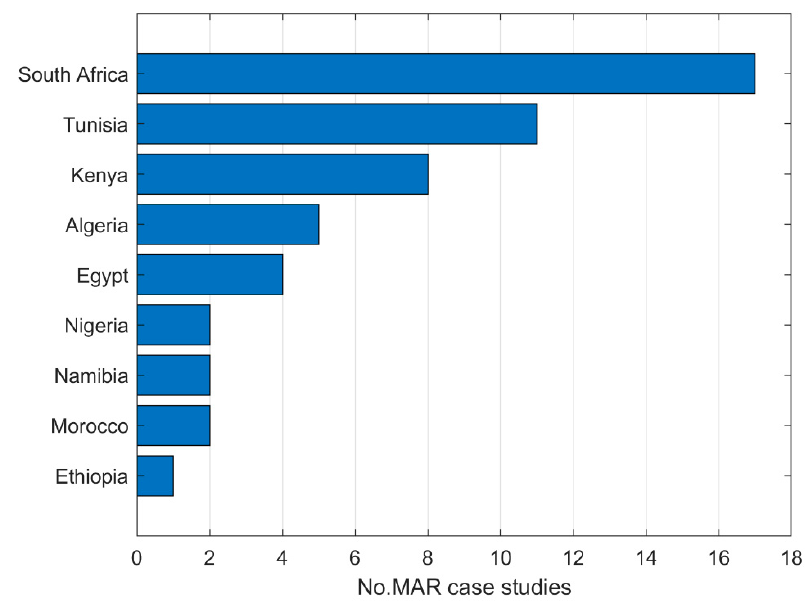
Figure 1. Number of MAR cases in Africa per country (n = 52).